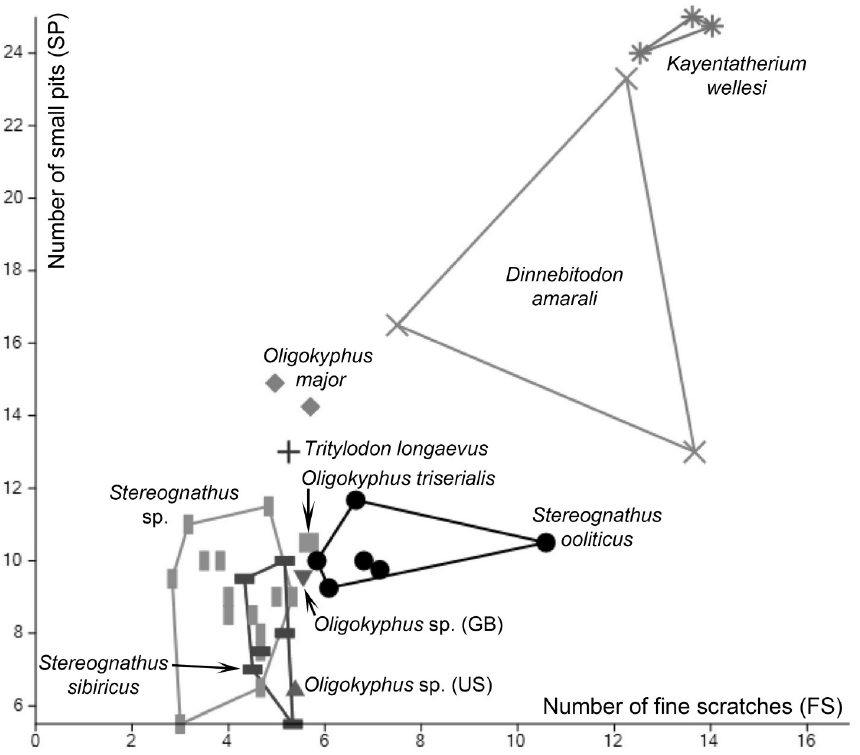
Fig 4. Bivariate plot of stereomicroscopic microwear parameters: Number of fine scratches (FS) versus number of small pits (SP). Convex hulls embrace the areas taken by taxa with N > 2; symbols represent individual means.